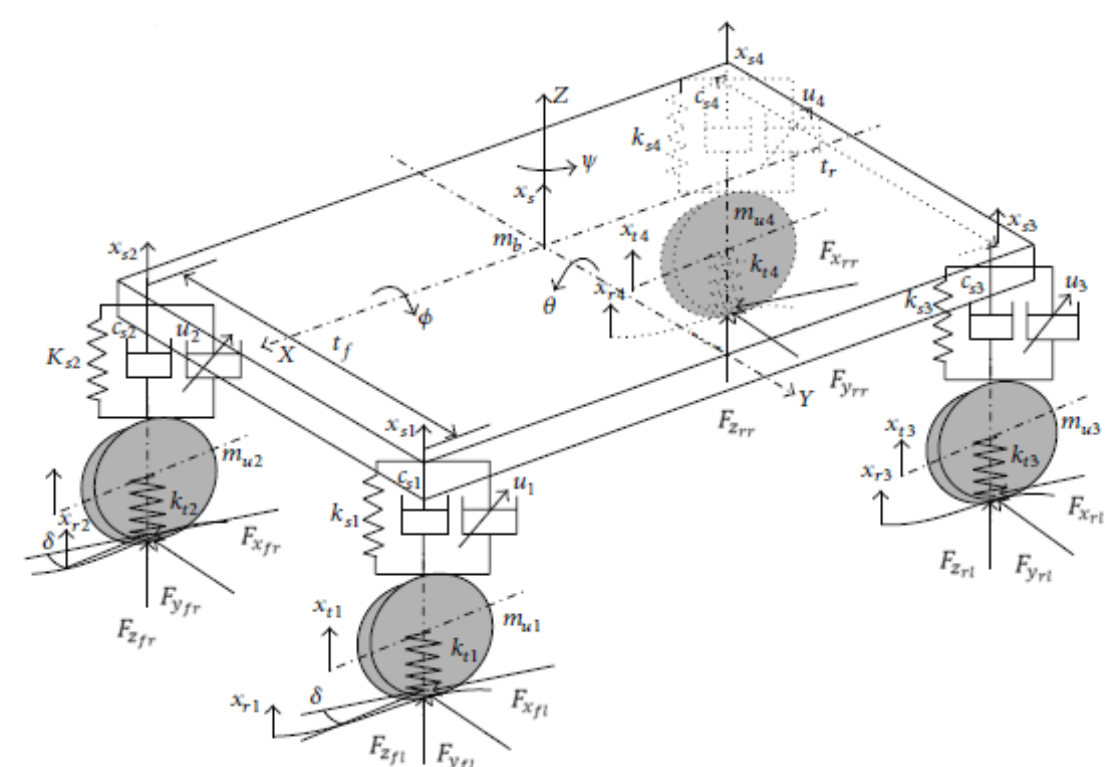
Figure 3. 1four-DoF vehicle dynamic model (adapted from